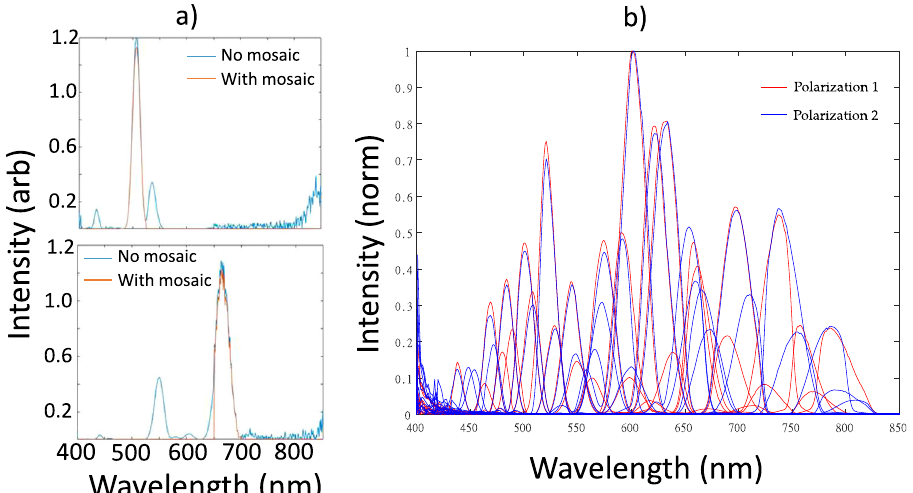
Fig. 1 Spectral characteristics of IRIS channels. a Measured spectral response of IRIS in two representative channels with and without the mosaic fi lter. Side lobes from the BSD alone are present in the spectrum. Interference fi lter mosaic removes side lobes in each channel. b Simulated spectral response of all channels overlaid on one